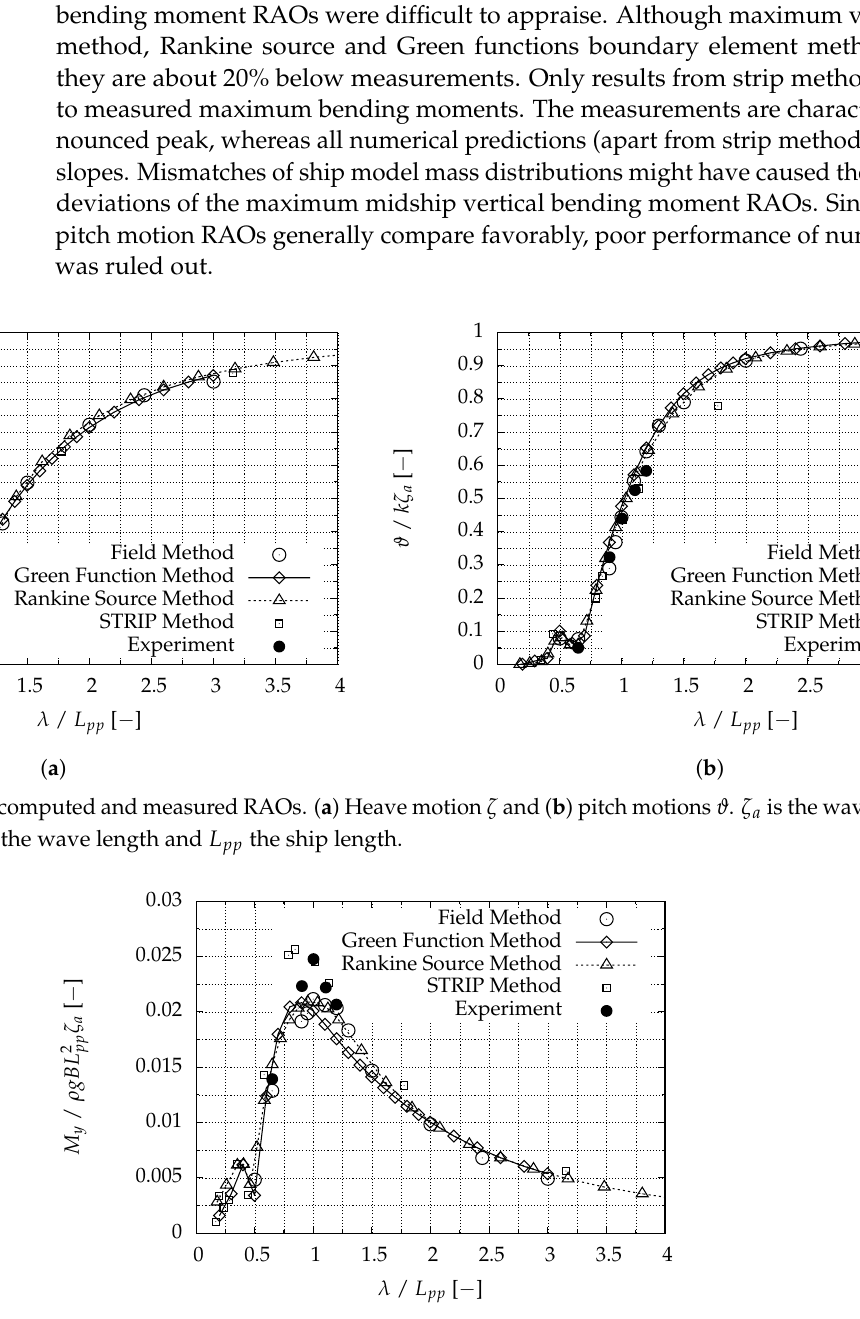
Figure 4. Cruise ship: computed and measured RAOs for midship vertical bending moment M y . ρ is the water density, g the gravity constant, B the ship’s breadth and L pp the ship